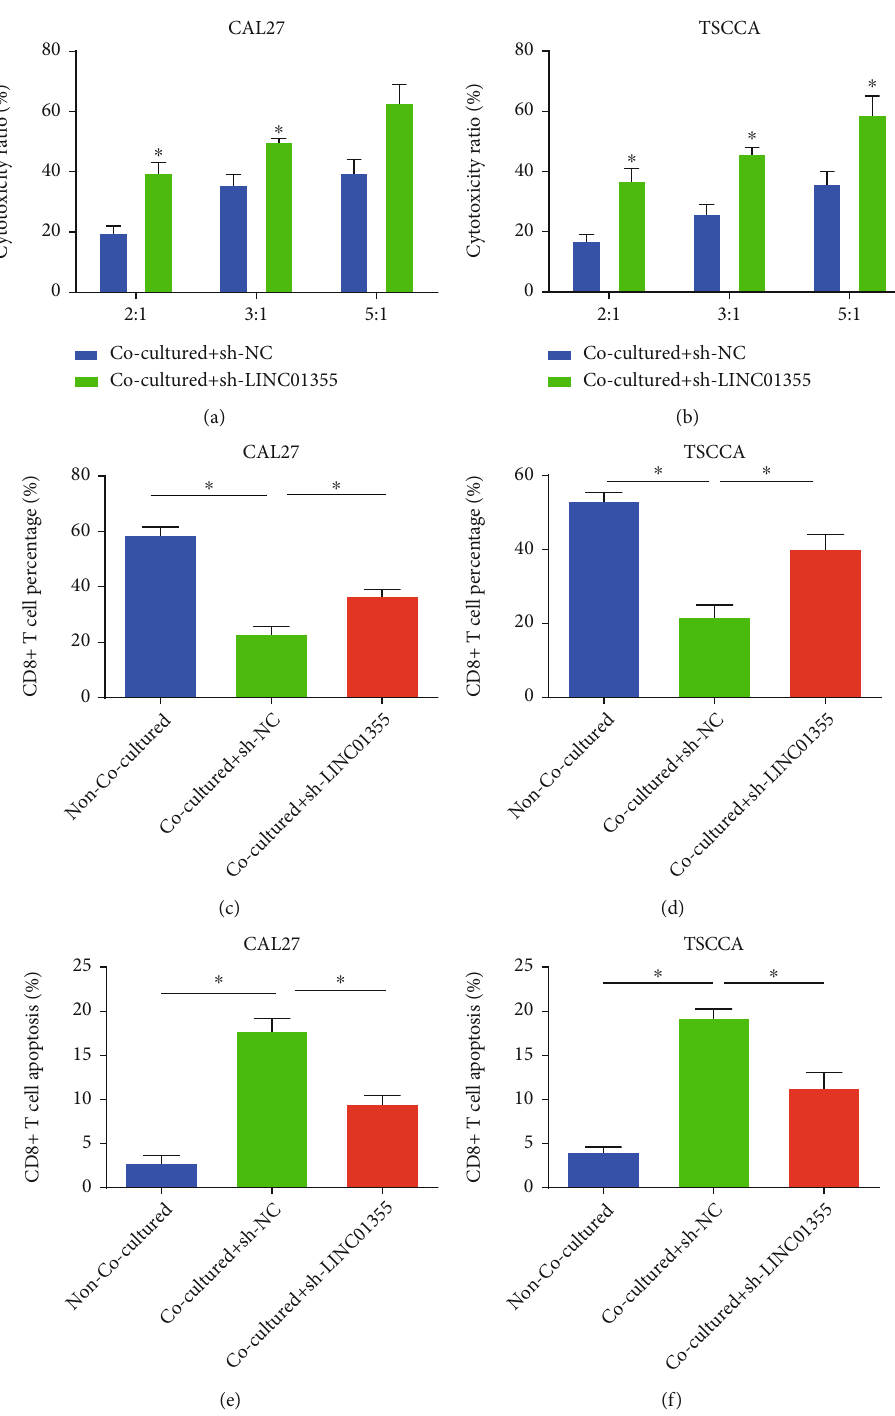
Figure 4: LINC01355 played a signi fi cant role in cytotoxicity, proliferation, and apoptosis of CD8+ T cells. The e ff ector CD8+ T cells were obtained from peripheral blood of healthy donors and cocultured with target OSCC cells. (a, b) The cytotoxicity of CD8+ T cells was assessed using a LDH Kit. (c, d) The proliferation of CD8+ T cells was tested by CFSE assay. (e, f) The apoptosis of CD8+ T cells was tested by fl ow cytometry. ∗ p < 0 : 05